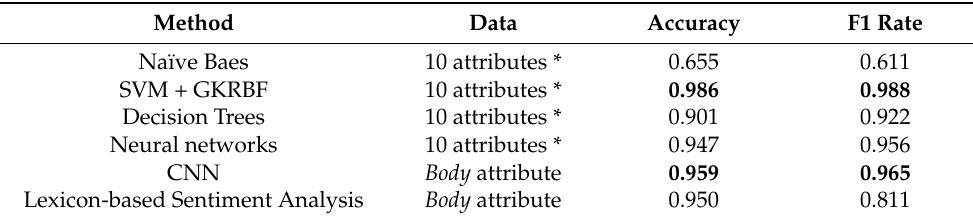
Table 13. Effectivity of models learned by all used methods for recognition of troll users in online discussions.